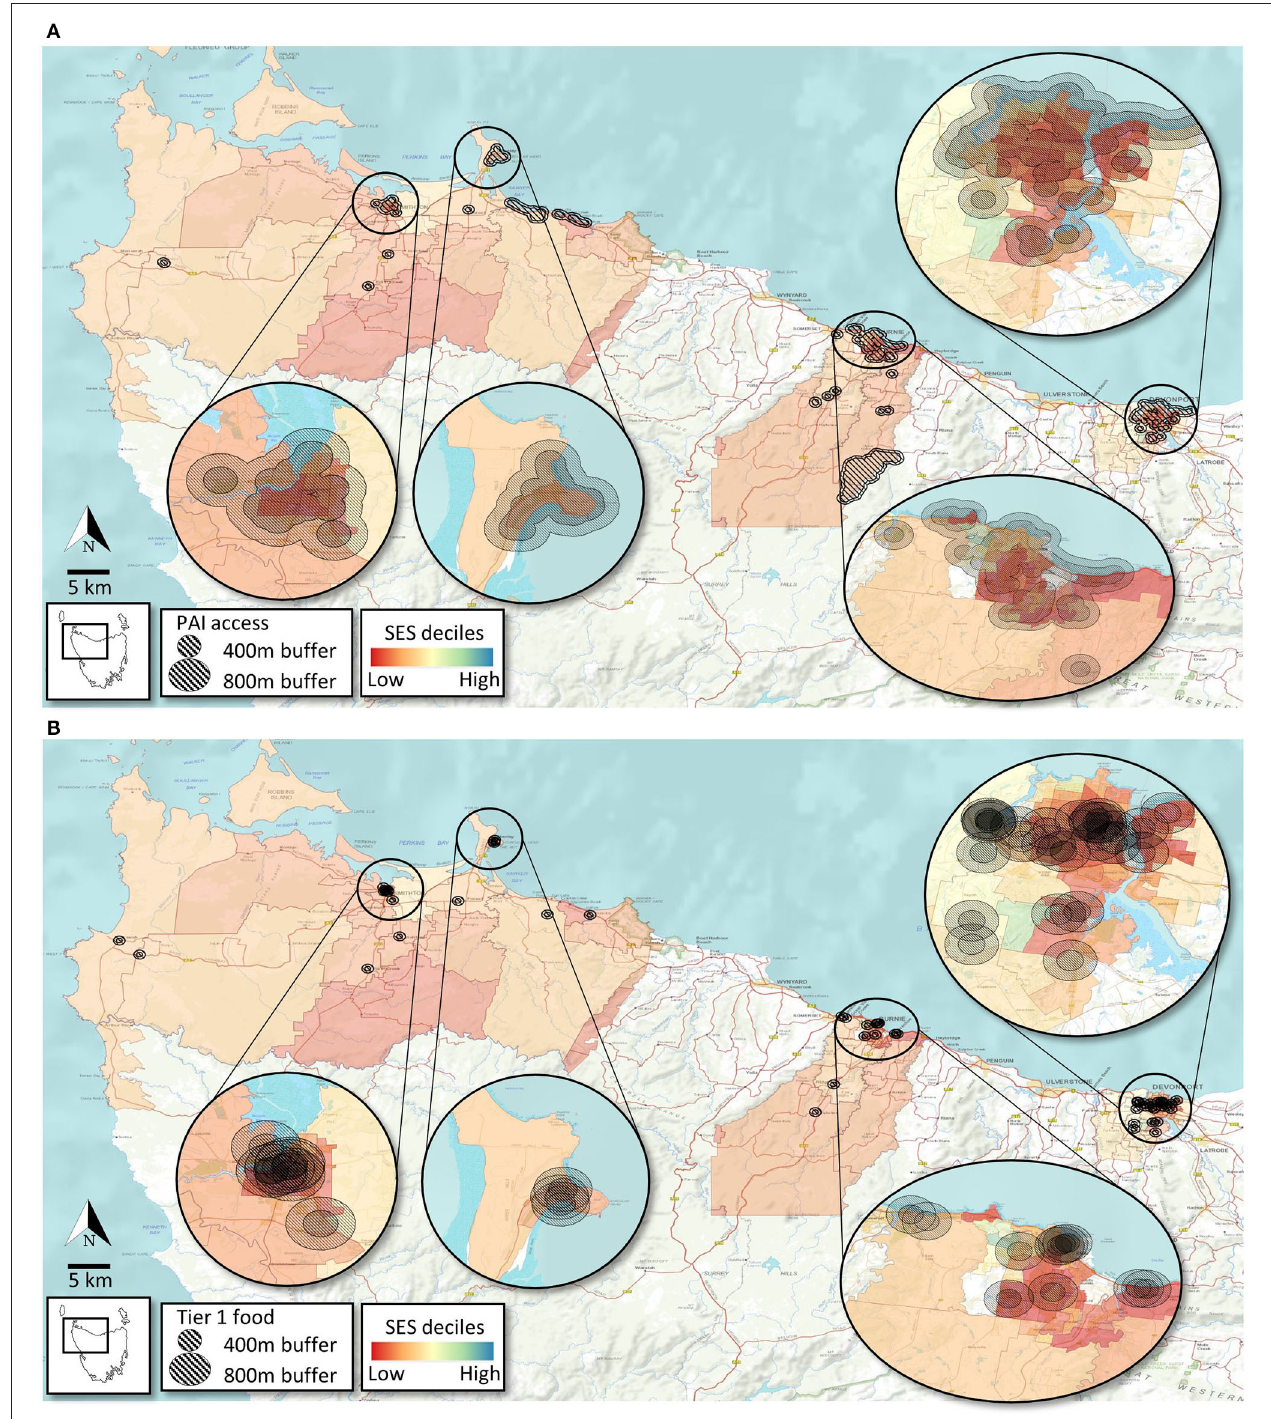
FIGURE 3 | Access to PA infrastructure (A) and Tier 1 food outlets (B) based on socioeconomic level of suburbs (SA1s) across the study